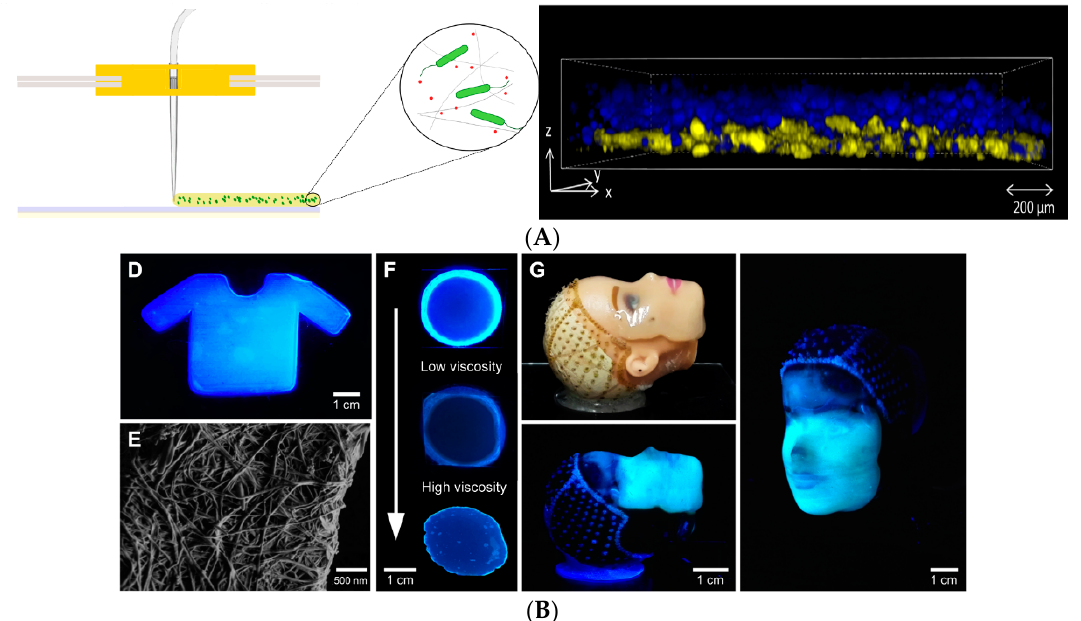
Figure 2. (A ) Modified strains of Escherichia coli contain blue fluorescent and yellow cells printed in